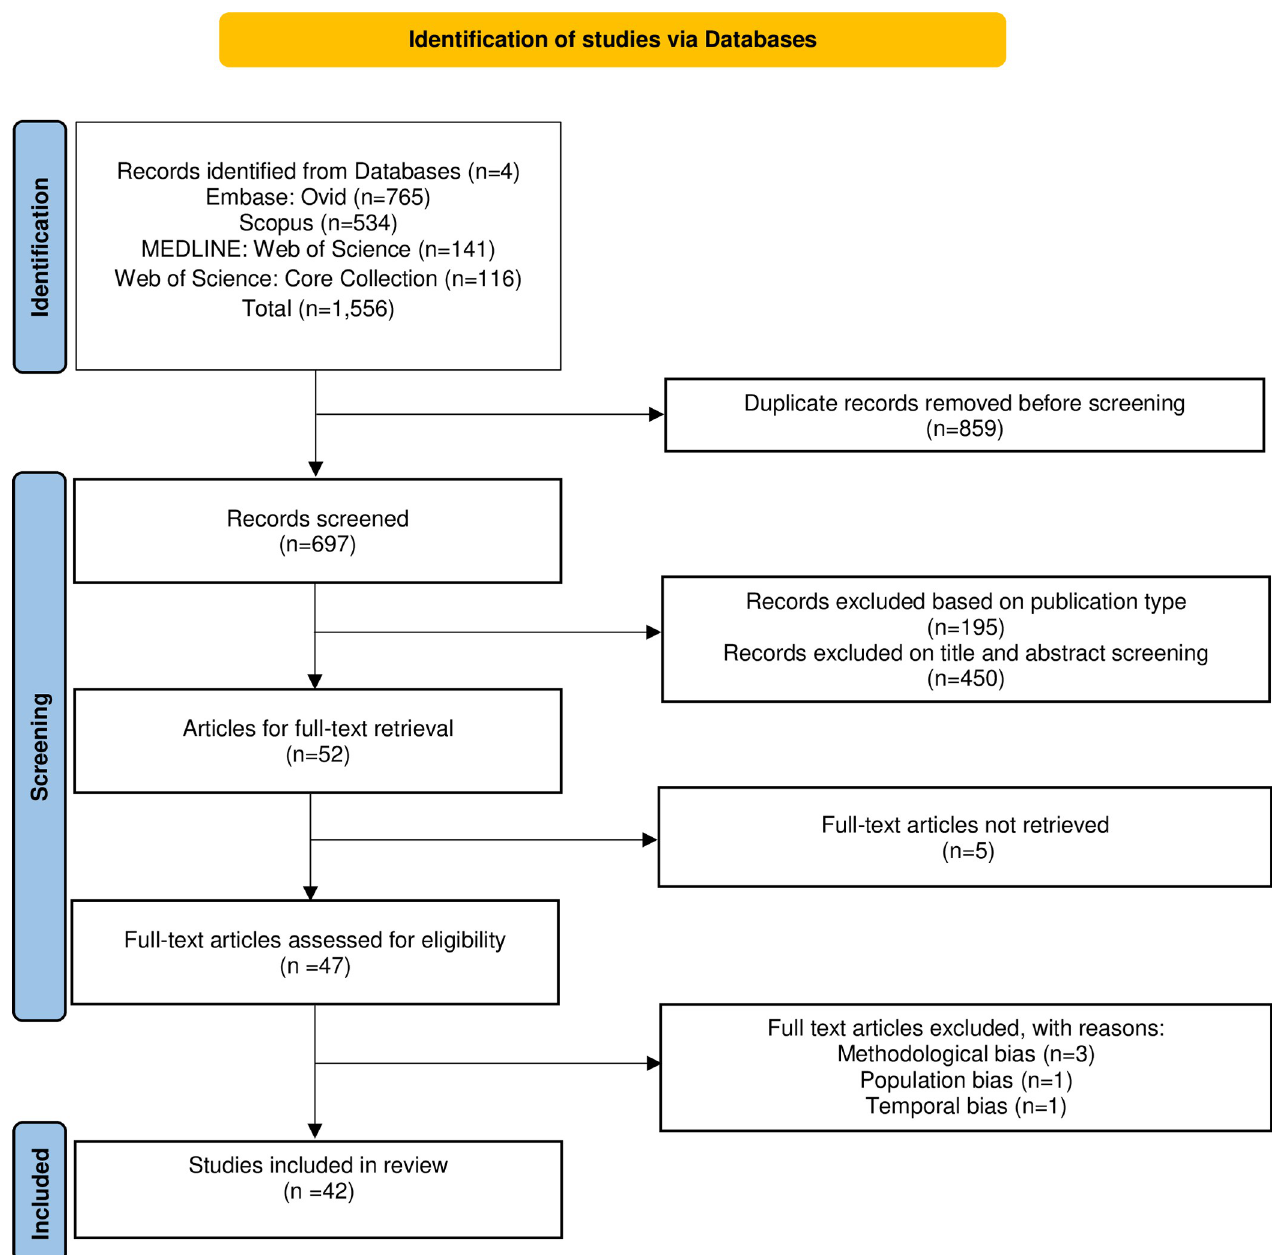
Fig 1. PRISMA flow diagram for a systematic scoping review of social media data and cannabis as a